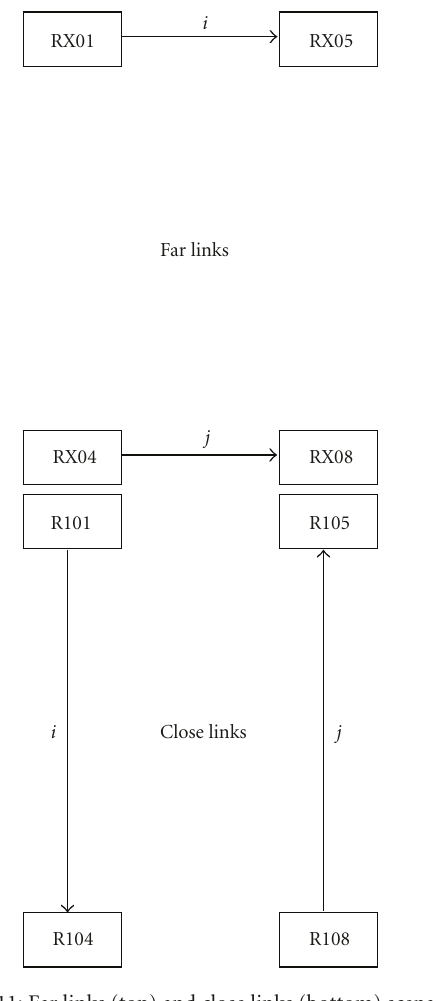
the transmission.